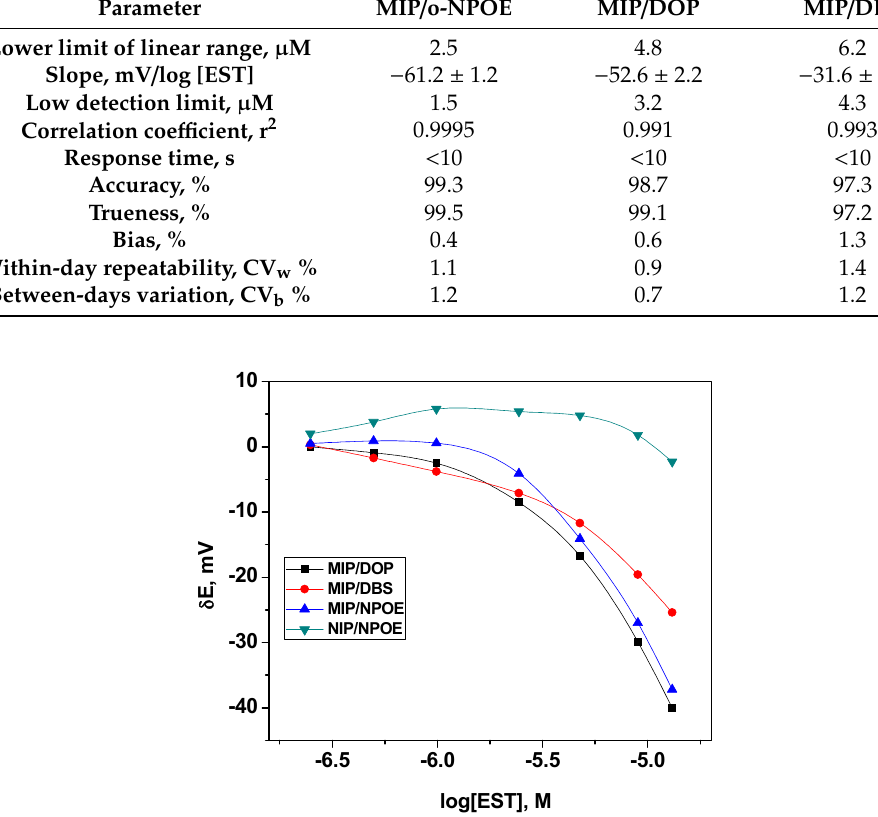
Table 1. Performance characteristics of 17 β -estradiol PVC membrane sensor in 50mM HCO 3 − /CO 32 − (pH 10.5).